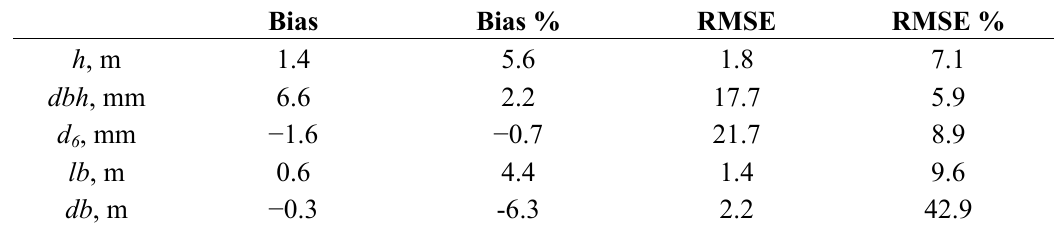
3. Tree variable measurement accuracy from TLS data. = diameter at 6-m height, lb = height of the dbh = diameter-at-breast height (1.3 m), d 6 lowest living branch and db = height of the lowest dead branch.